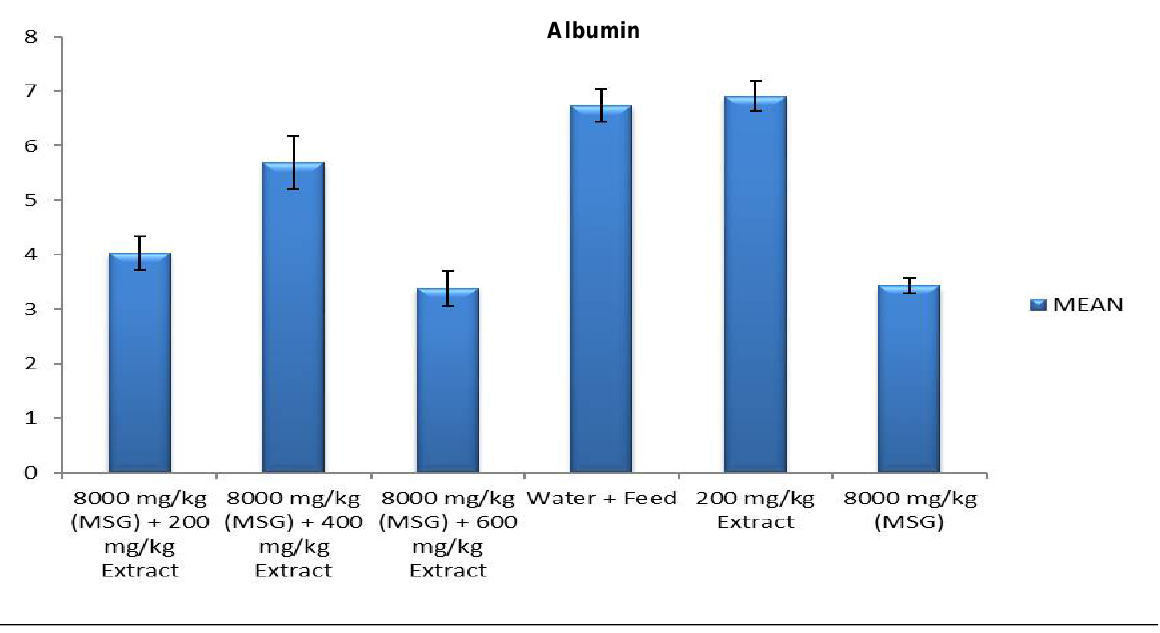
Figure 5: Effect of methanol extract of N. laevis on albumin concentration (mg/dl) of